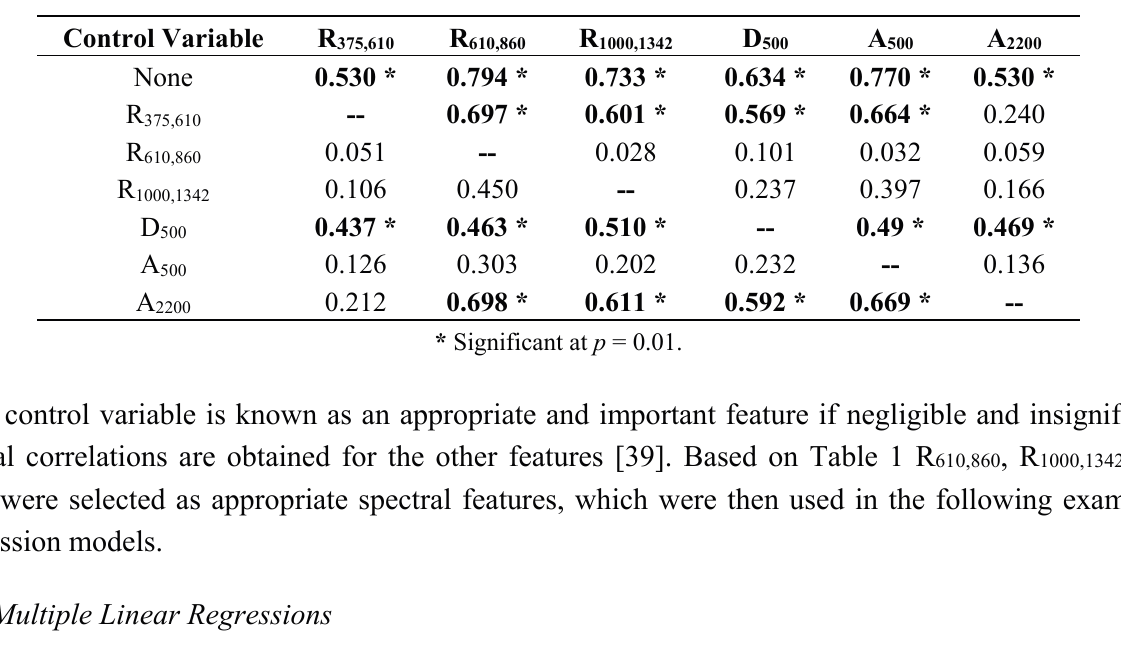
Table 2. Results of partial correlation coefficient statistical